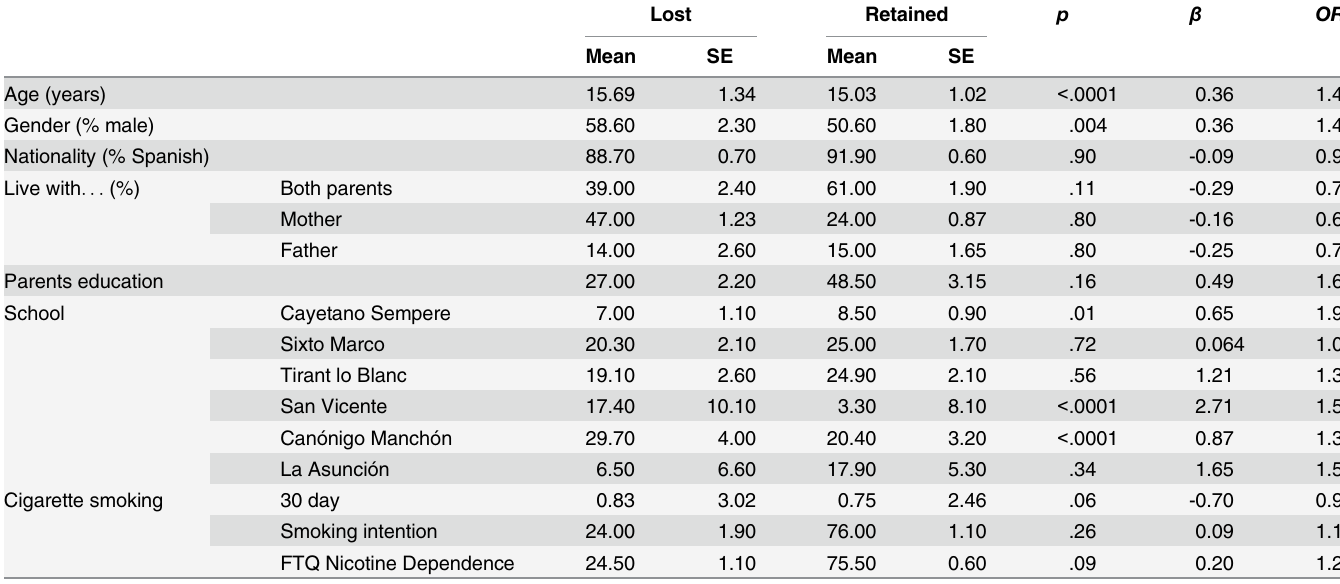
Table 2. Comparisons of key variables between lost-to-follow-up sample and subjects retained at one-year